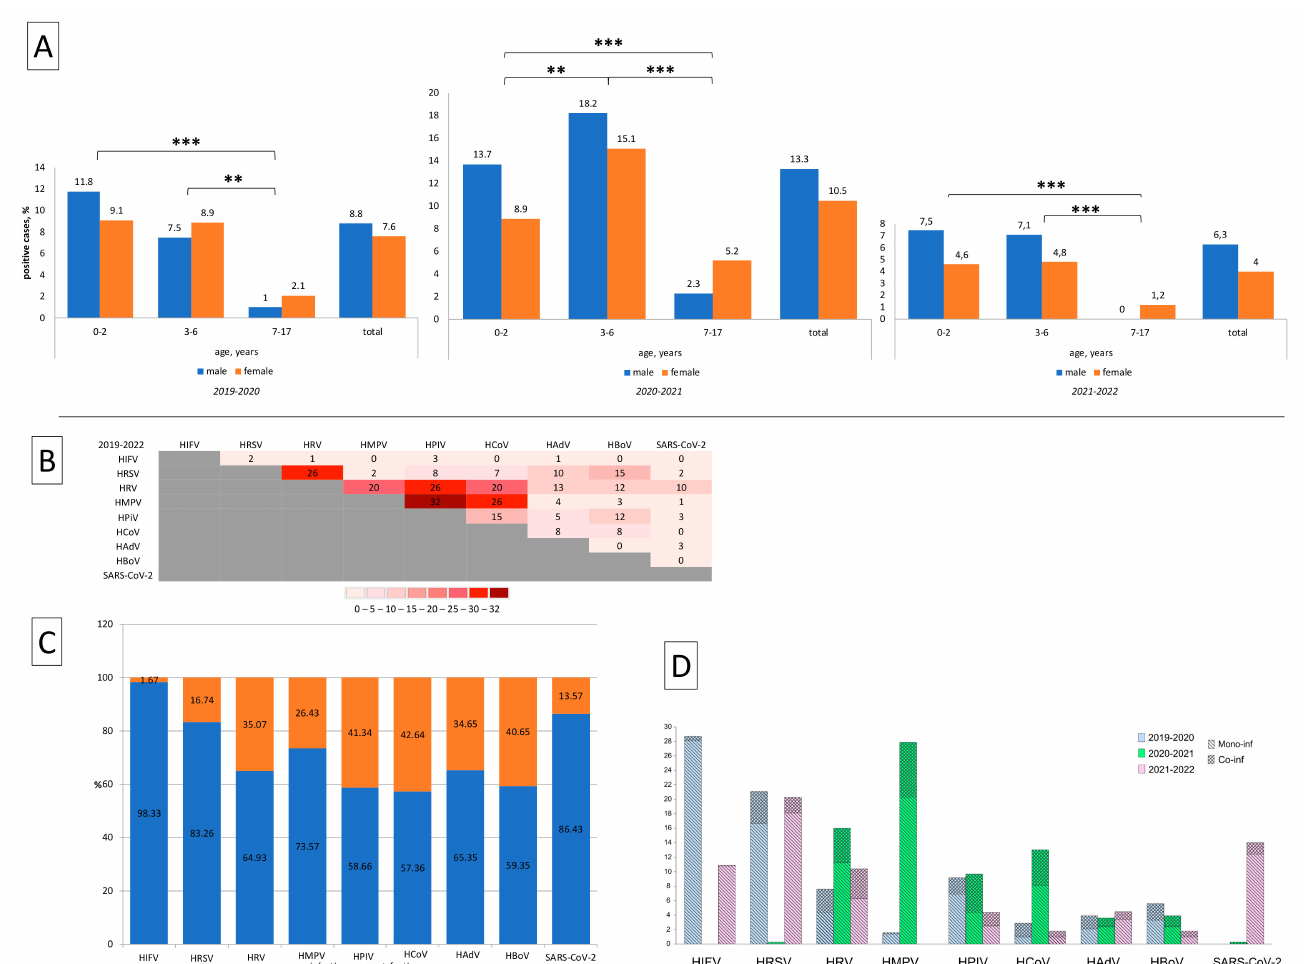
Figure 4. Incidence of co-infections among hospitalized patients aged 0–17 years during 2019–2022. ( A ) Age and gender distribution data of co-infected children and adolescents. ( B ) This figure displays the observed co-infection for each pairing. The co-infection data are plotted as a heat map to aid the visualization of any seasonal trends for each virus during 2019–2022, across all sites. All data are presented as the numerical data of the analyzed medical records of patients who were positive for co- infections during the three research periods. Abbreviations for ( B – D ): HIFV—influenza A and B viruses; HRSV—respiratory syncytial virus; HRV—rhinovirus; HPIV—parainfluenza virus types 1–4; HCoV— alphacoronaviruses (NL63/229E) and betacoronaviruses (OC43/HKU1); HMPV—metapneumovirus; HBoV—bocavirus; HAdV—adenovirus; and SARS-CoV-2—severe acute respiratory syndrome coron- avirus 2. ( D ) Mono-inf—mono-infection; Co-inf—co-infections. Numbers represent relative frequencies (%). *** and **—Differences between groups were statistically significant (Chi-square test, p < 0.01 and p < 0.05,